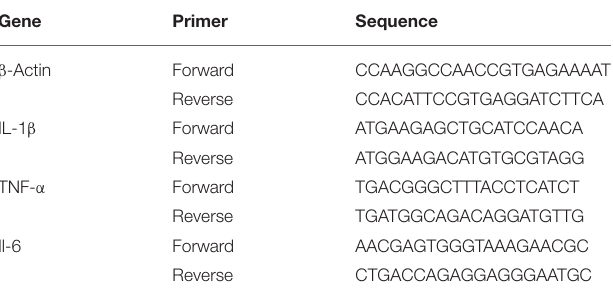
TABLE 1 | Primer sequence of inflammatory related